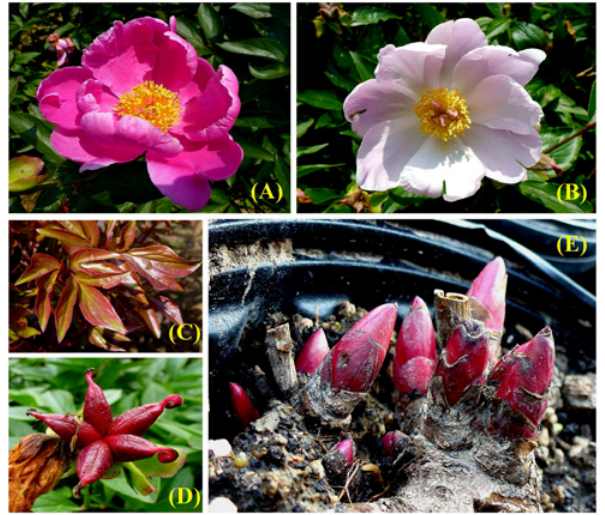
Fig 1. Ornamental organs and experimental samples of P . lactiflora ‘ Hangbaishao ’ . (A) The pink purple flower in the early florescence stage. (B) The pink white flower in the end of florescence stage. (C) The purple red young leaves. (D) The purple red ripe fruits. (E) The underground renewal buds sampled for deep sequencing and transcriptome research.